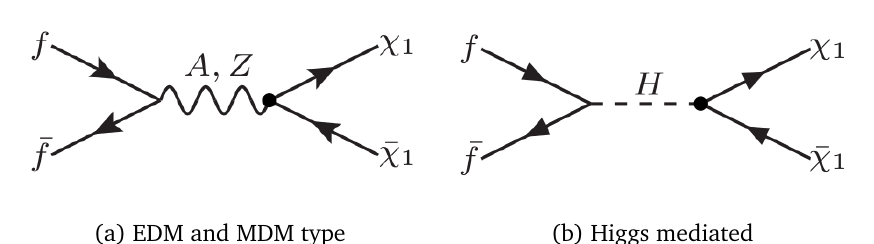
Figure 1: The 2 → 2 annihilation channels relevant for dark matter freeze-in. A , Z , H stand for the photon, Z and the Higgs fields. The blob represents the effective oper- ator. Additional diagrams with the W bosons initial states are not